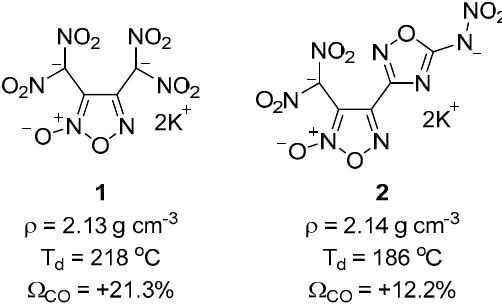
Figure 2. Structures and some physicochemical properties of dinitromethylfuroxanates.